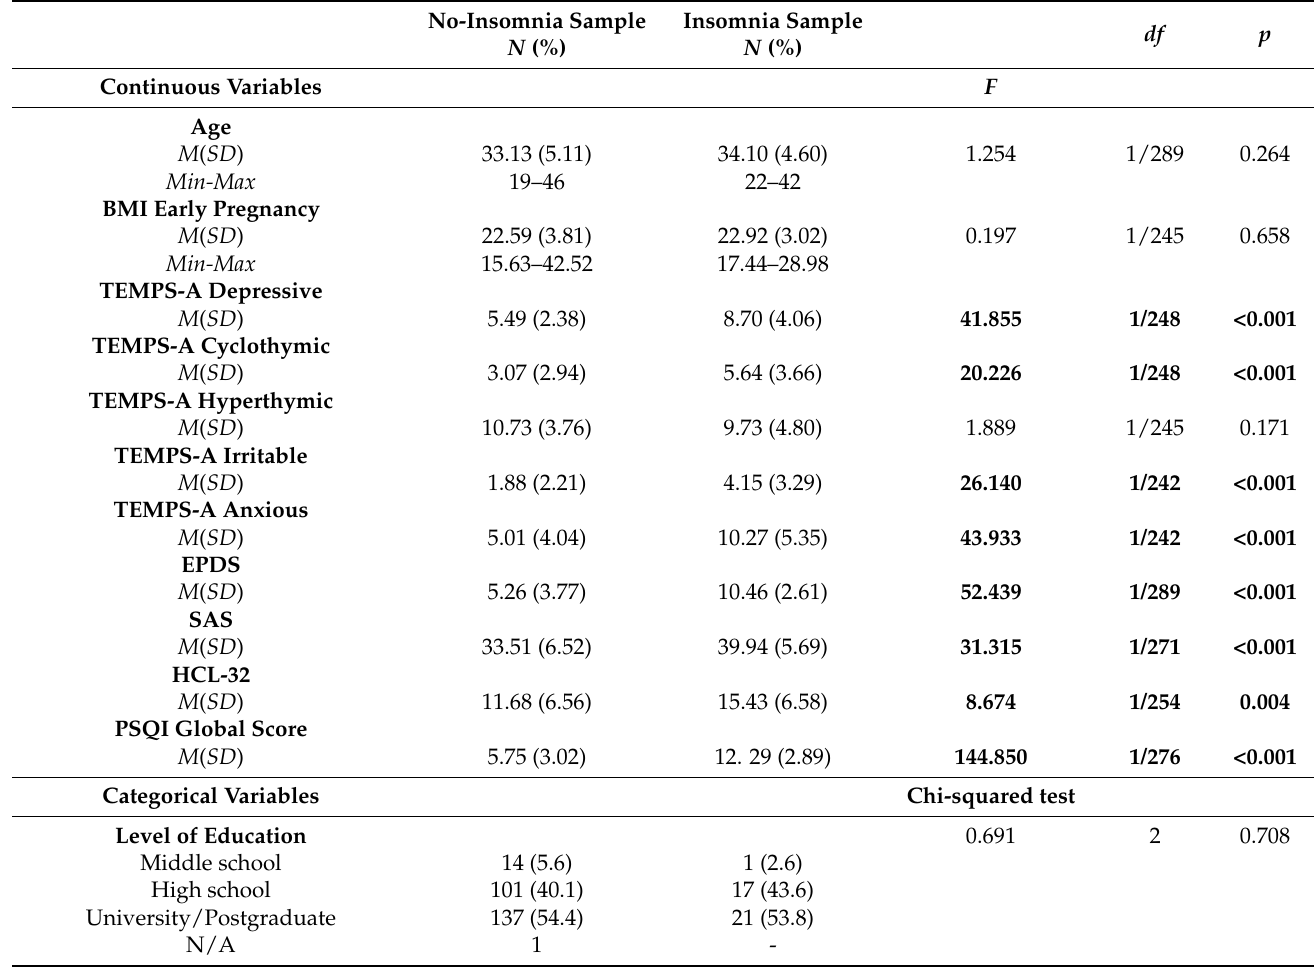
Table 1. Descriptive statistics of No-Insomnia and Insomnia